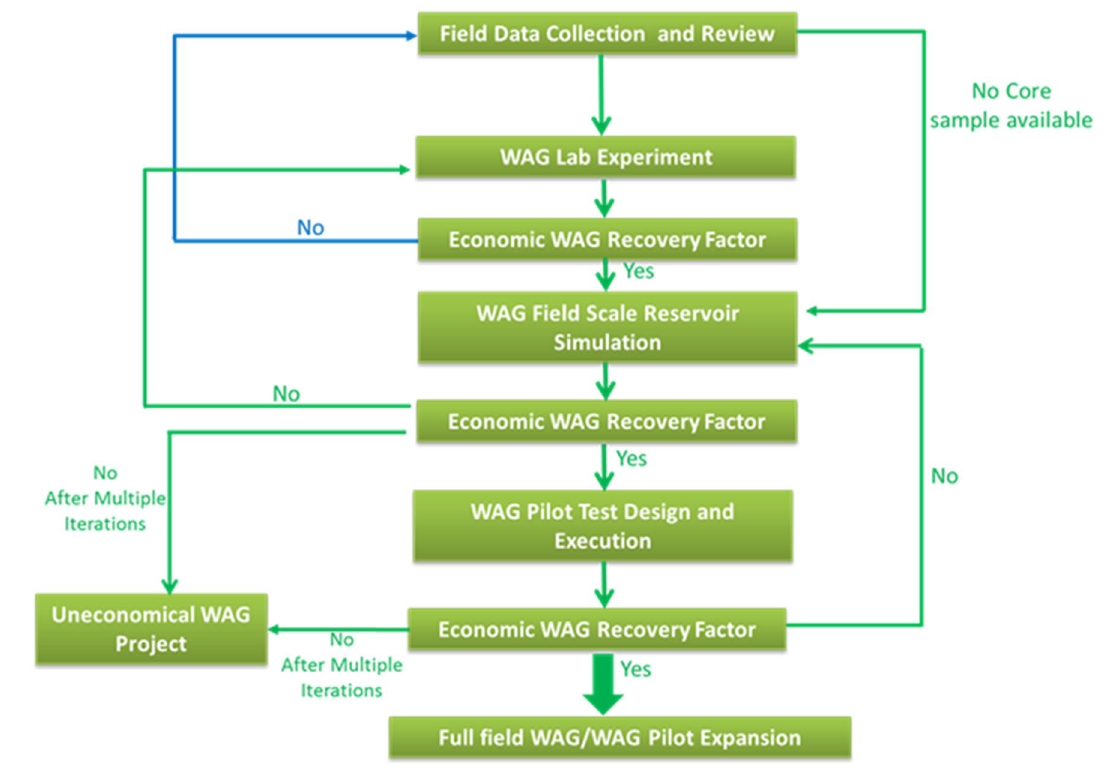
Fig. 1 Typical workflow for field-scale WAG project